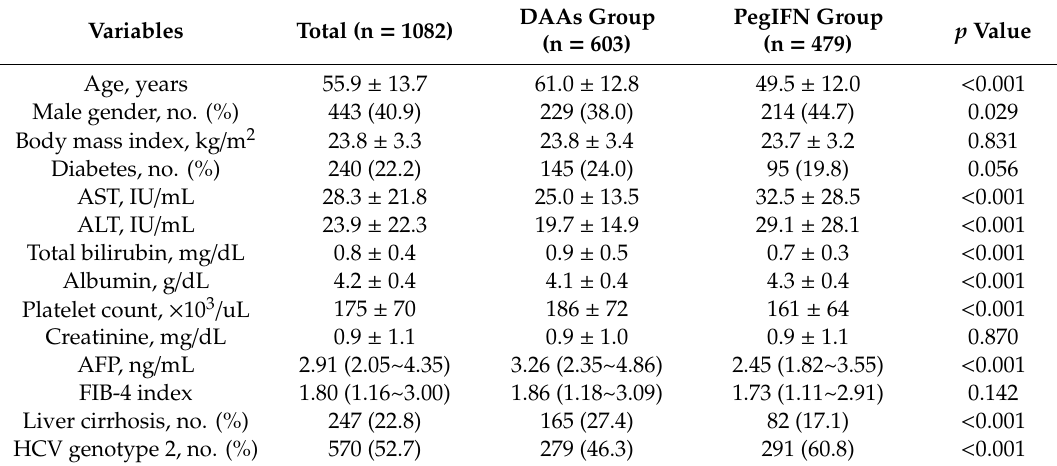
Table 1. Comparison of clinical characteristics at the time of sustained virological response (SVR) between two groups (n = 1082).